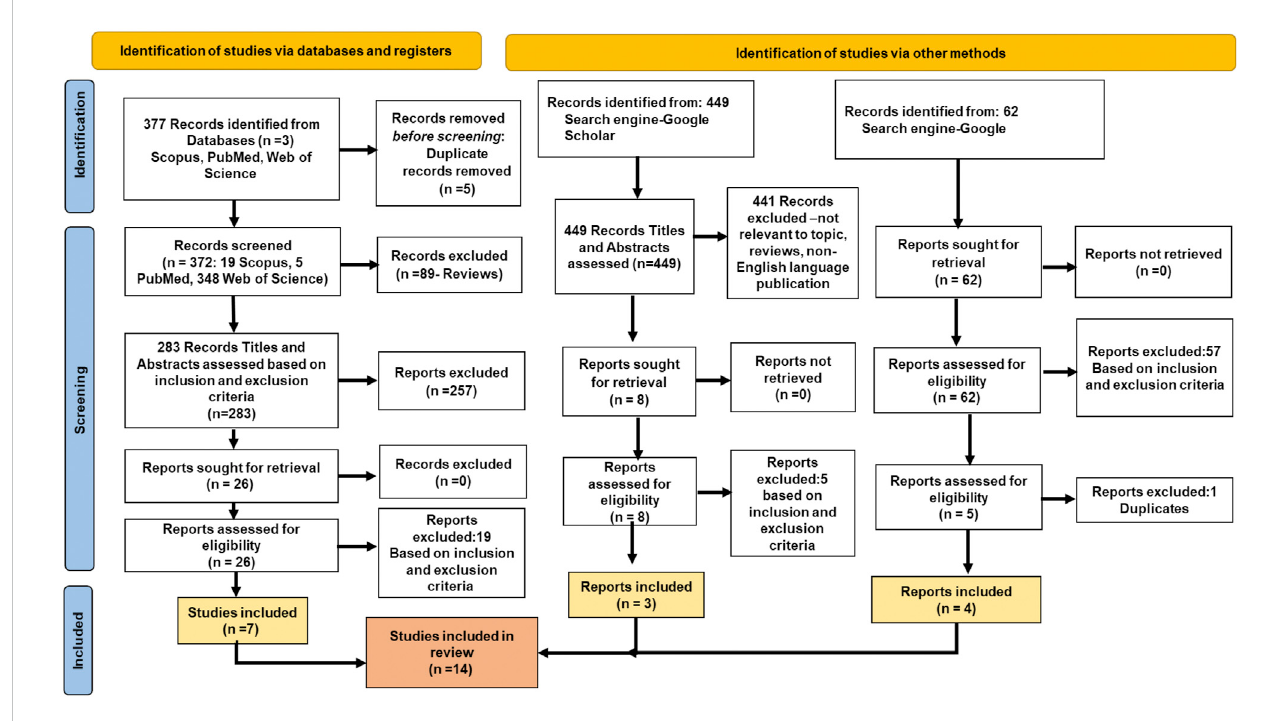
FIGURE 1 Search Strategy- PRISMA fl ow